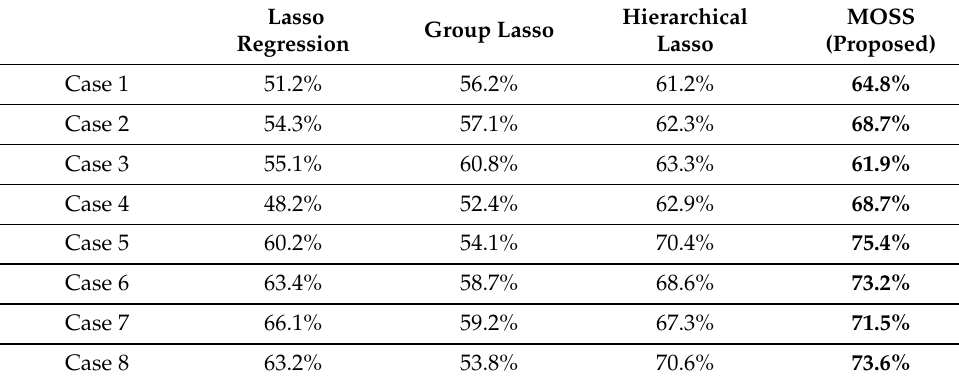
Table 4. Average Variable Selection Recall of Each Simulation Case.